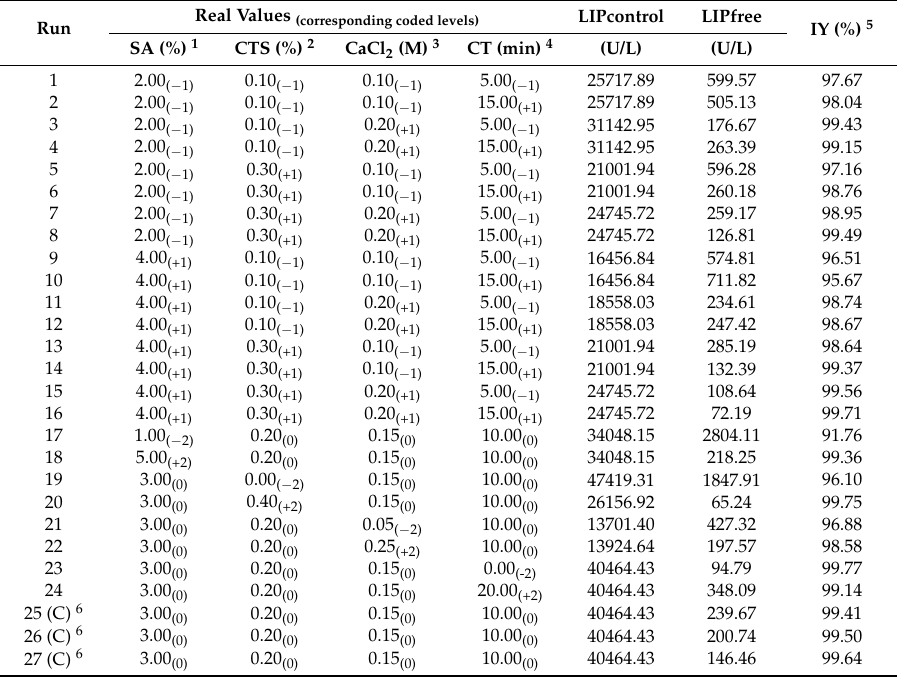
Table A1. Matrix of experimental runs for Central composite rotatable design (CCRD) for immobilization yield with values of LIPcontrol and LIPfree. IY (%) = (LIPcontrol − LIPfree) × 100/LIPcontrol. Real Values (correspondingcodedlevels) Run